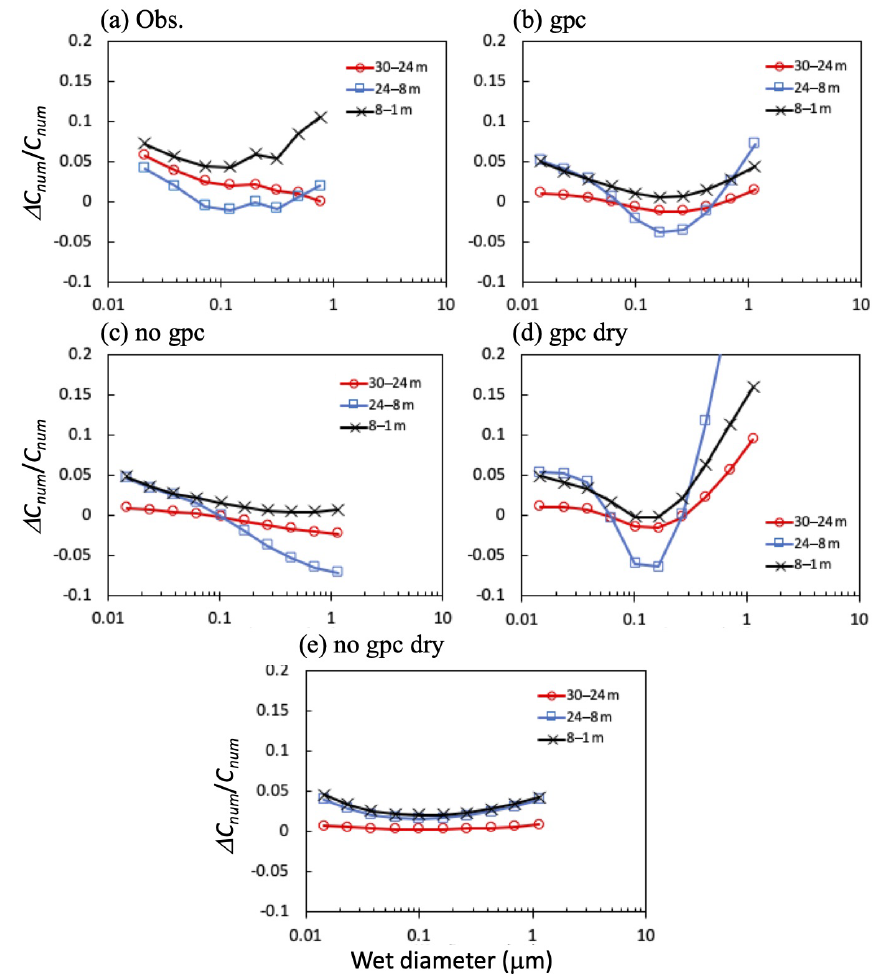
Figure 11. Differences ( (cid:49)C num ) in (a) observed and (b–e) calculated mean total number concentrations ( C num ) between height pairs for 11:00–17:00 on 7, 8, 25, and 30 November 2016. Four calculation scenarios are presented in the figure: (b) gpc, (c) no gpc, (d) gpc dry, and (e) no gpc